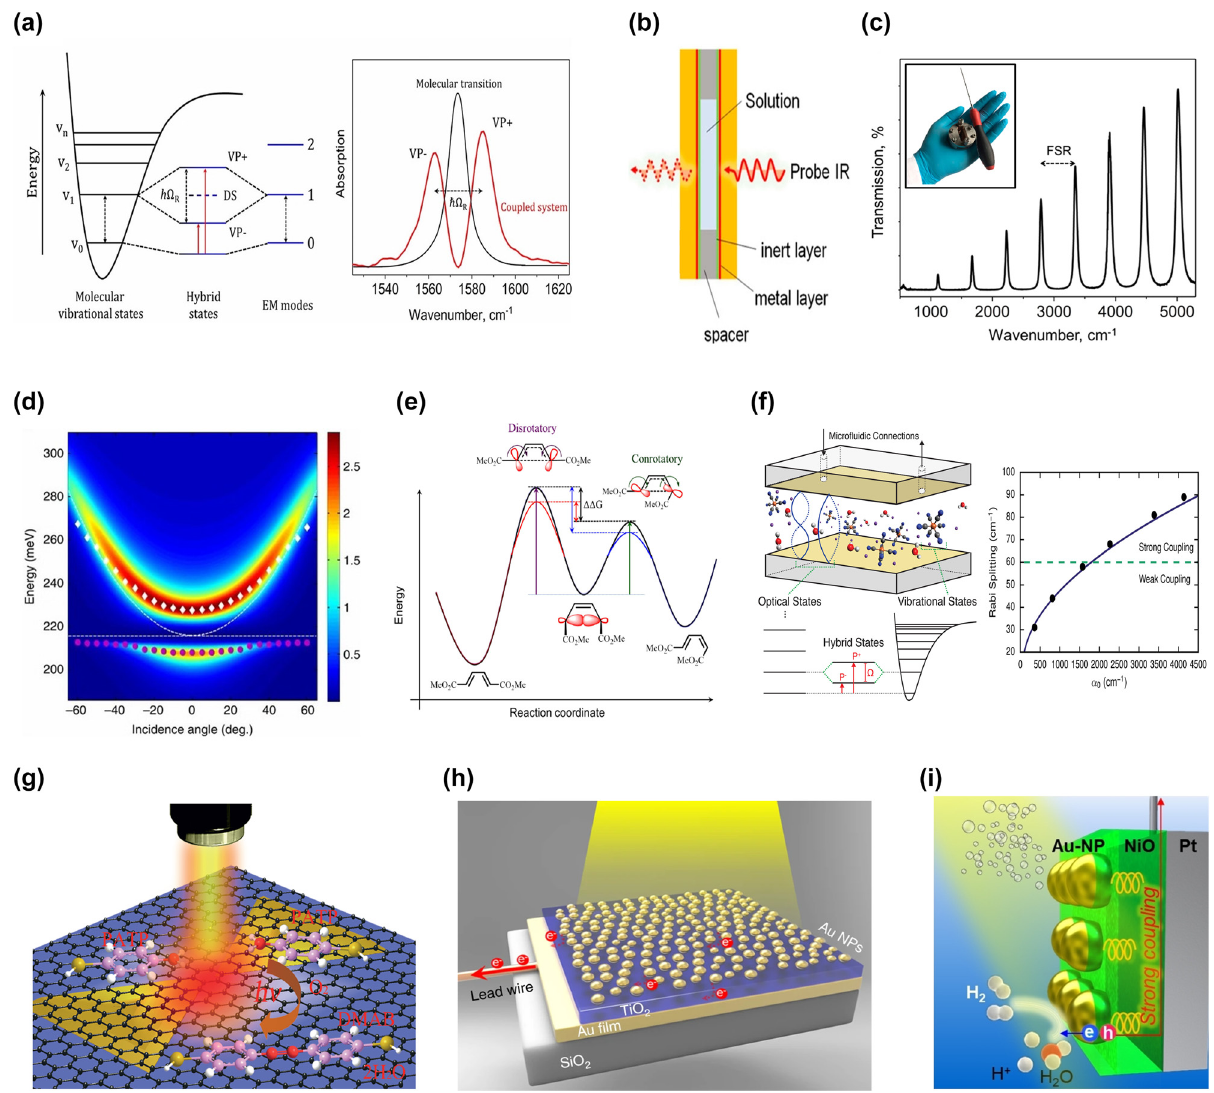
Figure 4: Modifying chemical reaction kinetics via coupling to cavity mode or plasmon mode. (a) Energy diagram (left) and Rabi splitting (right) of vibro-polaritonic strong coupling. (b) Schematic diagram of Fabry–Pérot microcavities. (c) Air-filled cavity resonance in FTIR transmission spectrum. The inset image is Fabry–Pérot microcavities and screwdriver to tune cavity length. (d) Optimal fitting calculation results from experimental-based data. Purple circles and white diamonds are real measured data. (e) Comparison of energy level diagrams of chemical reaction under noncavity or VSC mode. Gibbs free energy change ( ΔΔ G ) is modified by VSC to C = O (blue) and C–H (red). (f) Schematic showing the microfluidic cavity device and the energy state (left panel). Rabi splitting strengths for maximum absorption coefficient and boundary (green dot) between weak and strong coupling (right panel). (g) Strong plasmon–exciton coupling between Ag bowtie and graphene co-driven conversion reaction from PATP to DMAB. (h) Schematic of plasmon–cavity nanostructure that generates modal strong coupling. (i) Water reduction process using photocathode composed of ANP structure. The pictures are reproduced